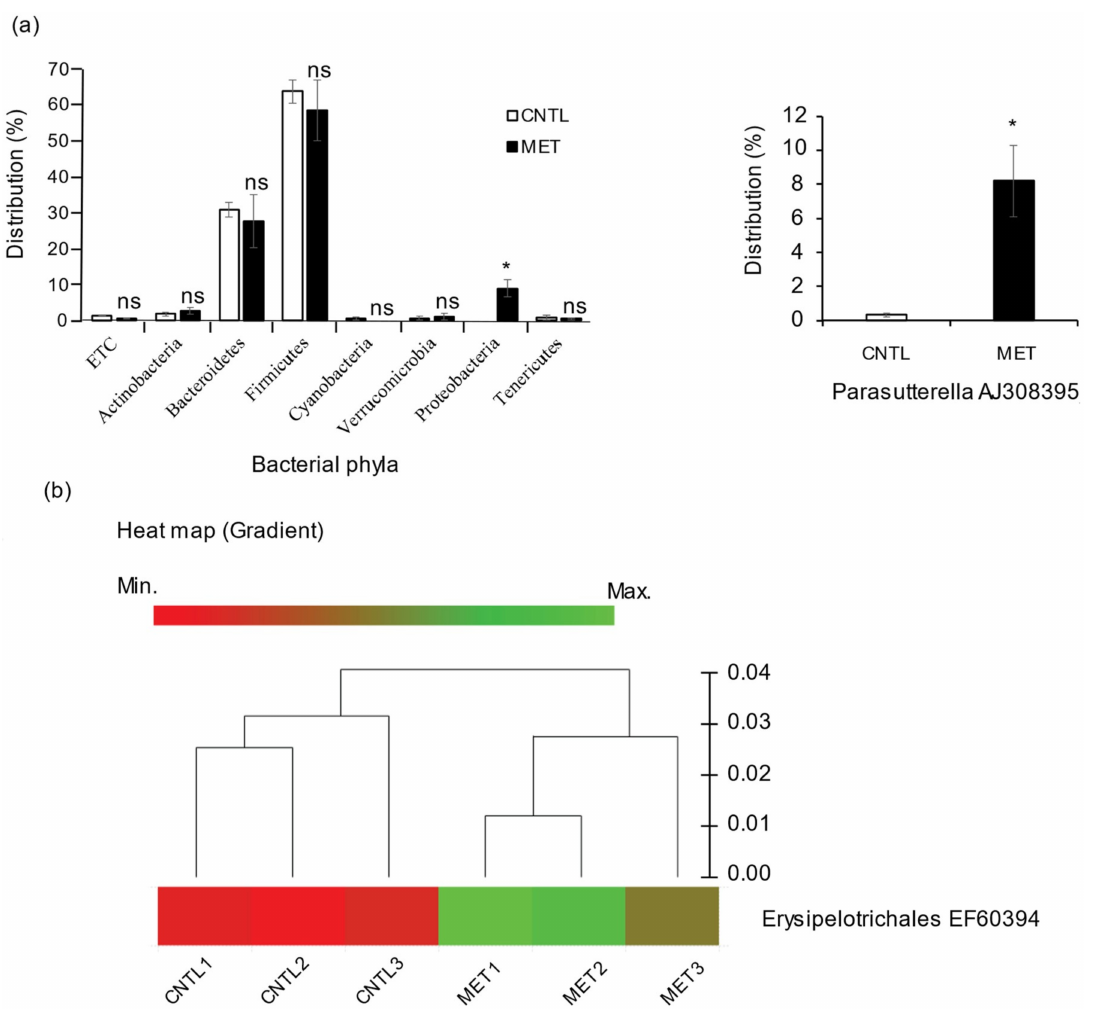
Figure 1. Metronidazole enhances susceptibility to colonization by Proteobacteria and enrichment of Erysipelotrichales . 16s rRNA genes were sequenced from DNA extracted from the fecal pellets of metronidazole (MET)-treated and nontreated control (CNTL) specific pathogen–free (SPF) mice. ( a ) Percentage representation of the bacterial phyla distribution in fecal pellets of metronidazole-treated and nontreated control SPF mice demonstrating increased susceptibility to colonization by Proteobacteria , especially Parasutterella . N = 3 mice per group. Data are presented as means ± standard error of the mean (SEM). Asterisks indicate statistically significant differences (*, p < 0.05; ns, nonsignificant with student’s t test). ( b ) Gradient heatmap showing enrichment of the bacterial species Erysipelotrichales in metronidazole-treated SPF mice as compared to nontreated controls. Relative abundance of the bacterial species is color coded from minimum (red) to maximum (green). N = 3 mice per nontreated control (CNTL1–3) and metronidazole-treated (MET1–3)